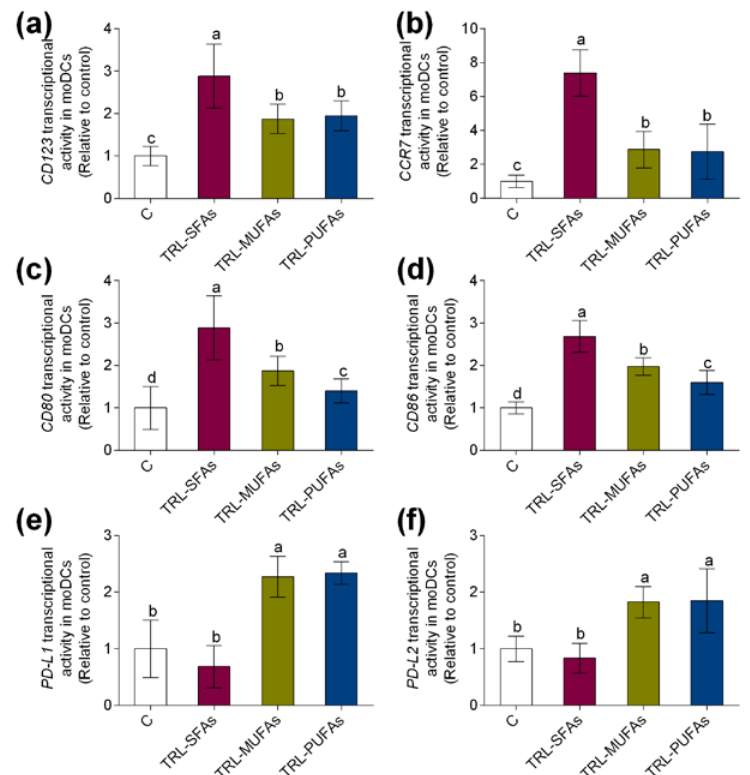
Figure 2. In vitro expression of dendritic cell (DC) gene markers in monocyte-derived DCs (moDCs) after stimulation with TRL-SFAs, TRL-MUFAs and TRL-PUFAs (TRL, triglyceride-rich lipoprotein) at 100 µg of TGs/mL for 6 days and in presence of GM-CSF and interleukin-4 (IL-4). DC maturation markers: ( a ) CD123 and ( b ) CCR7. DC pro-inflammatory activation markers: ( c ) CD80 and ( d ) CD86. DC tolerogenic activation markers: ( e ) PD-L1 and ( f ) PD-L2. Control means non-treated cells in the presence of GM-CSF and IL-4. Values are presented as means ± SD ( n = 6) and those marked with different letters are significantly different ( p < 0.05).